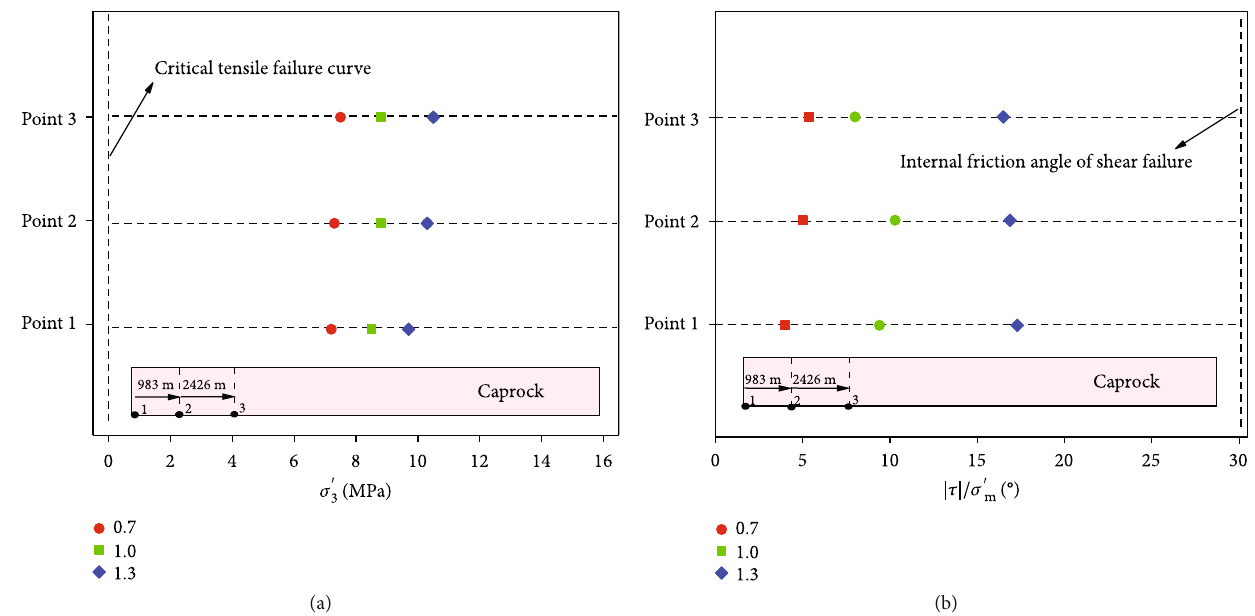
Figure 22: In fl uence of in situ stress level on mechanical integrity of caprock. (a) The minimum principal stress. (b) Critical internal friction angle.